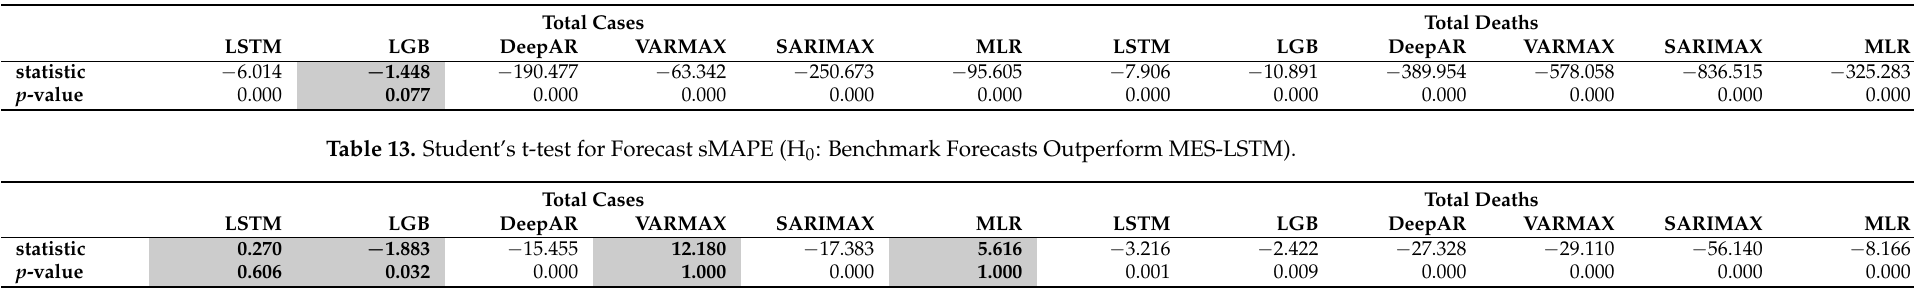
Table 12. Student’s t-test for Forecast RMSE (H 0 : Benchmark Forecasts Outperform MES-LSTM).